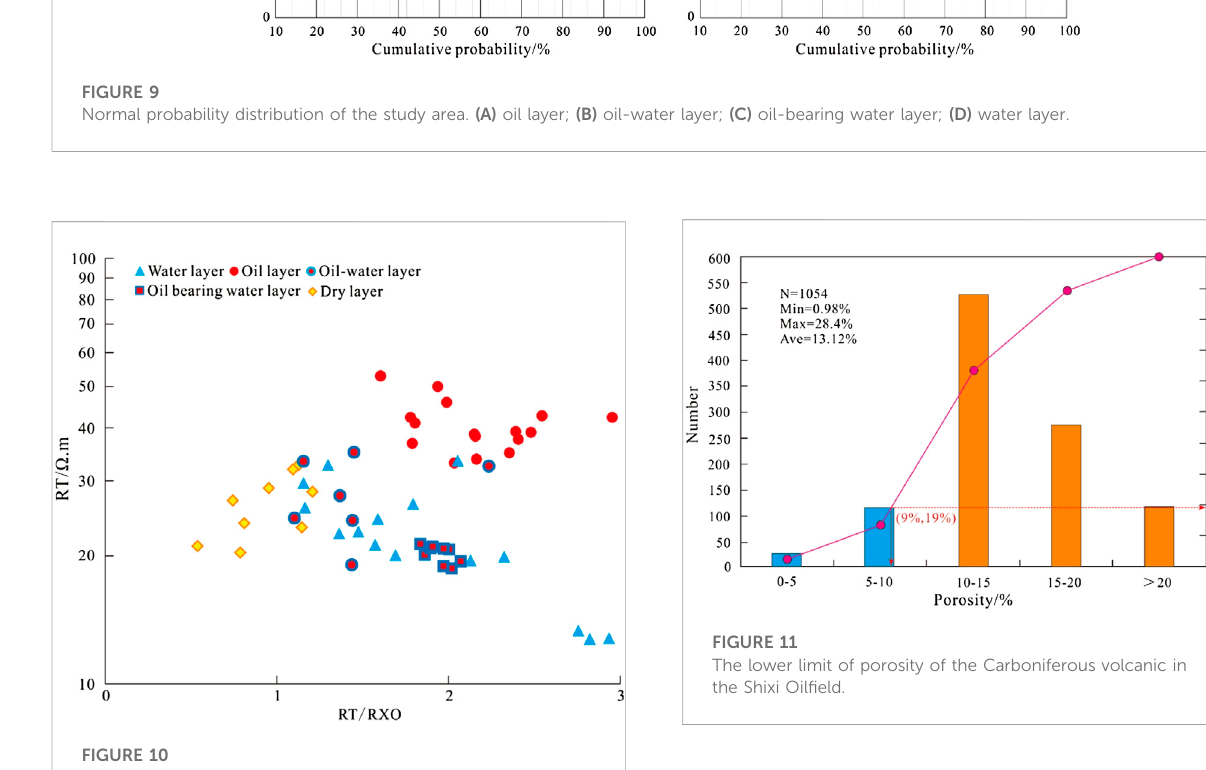
FIGURE 10 Rt/Rxo and Rt cross-plot of the Carboniferous volcanic in the Shixi Oil fi eld.